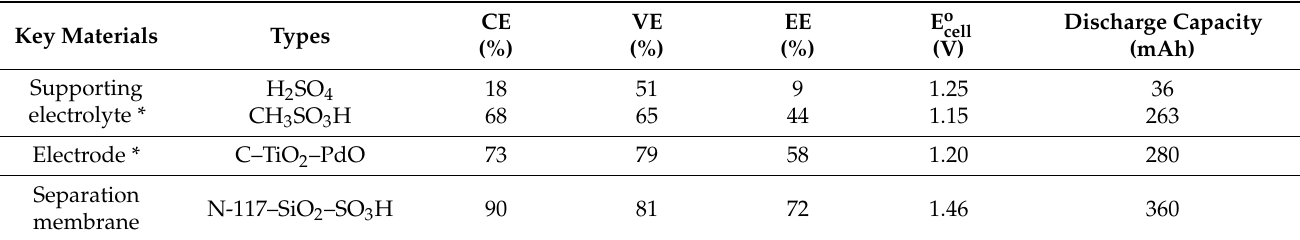
Figure 7. Charge–discharge diagrams of a Ce/ascorbic acid/I RFB system with H 2 SO 4 or CH 3 SO 3 H as positive supporting electrolyte ( a ) 1.0 M Ce(NO 3 ) 3 /2.0 M H 2 SO 4 ( b ) 1.0 M Ce(NO 3 ) 3 /2.0 M CH 3 SO 3 H. Other components: 1.0 M I 2 /0.20 M ascorbic acid/2.0 M H 2 SO 4 as a negative electrolyte, Nafion 117 as a membrane, and carbon papers as positive/negative electrodes, as well as two staggered-type flow channels at a current density of 20 mA/cm 2 and 20 mL of electrolyte solutions. Table 4. The performance of the Ce/ascorbic acid/I RFB system with various key components at the third lap charge– discharge test.